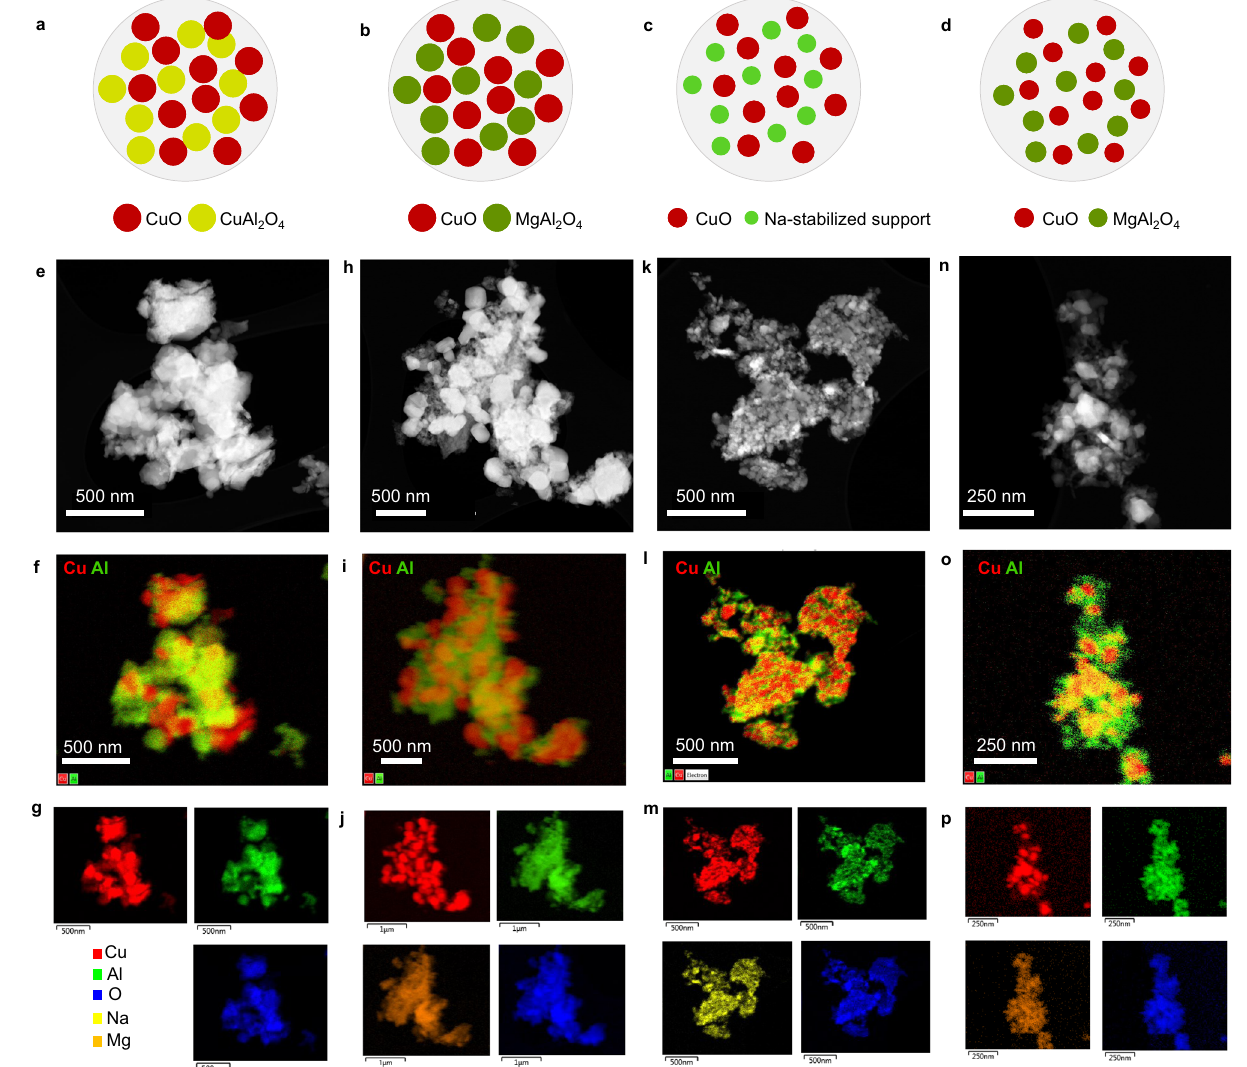
Fig. 3 | HAADF-STEM imaging and EDS elemental mapping of typical MMOs. Diagrams illustrating the composition and phase dispersion of the MMOs: a CuO/ CuAl 2 O 4 derived from CuAl-LDH, b CuO/MgAl 2 O 4 derived from low-crystallinity CuMgAl-LDH, c CuO in sodium-stabilized support, and d CuO in MgAl 2 O 4 support derived from high-crystallinity CuMgAl-LDH. e , HAADF-STEM image and ( f, g ) element mapping of CuAl-MMO synthesized from CuAl-LDH, consisting of CuO/ CuAl 2 O 4 . Cu:Al=3:2, 2M NaOH. h HAADF-STEM image and i , j element mapping of CuMgAl-MMOderived fromlow-crystallinityCuMgAl-LDH.MolarratioofCu:Mg:Al